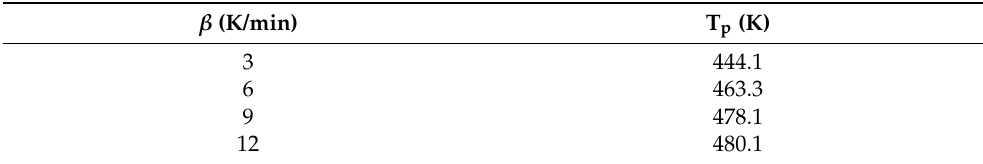
Table 1. DSC data at different heating